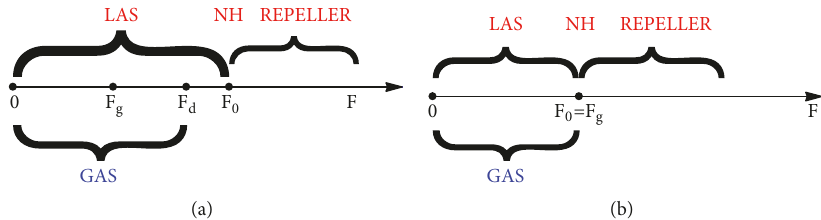
Figure 5: Visual representation of local and global asymptotic stability of Equation (1) when (a) 𝐹 𝑔 < 𝐹 𝑑 < 𝐹 0 , i.e., 𝑐 < 𝑏 , and (b) 𝐹 0 = 𝐹 𝑔 , i.e., 𝑐 = 𝑏 .